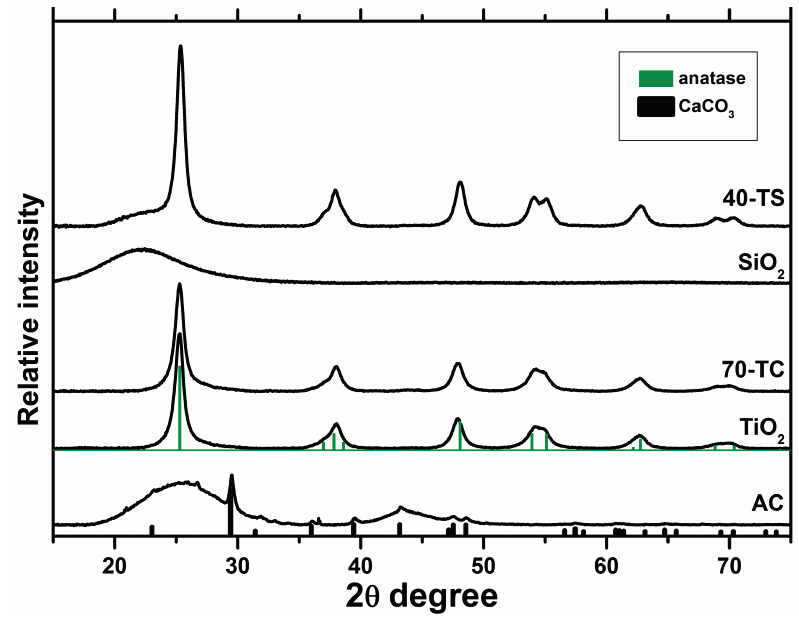
Figure 2. XRD patterns for the pure TiO 2 , AC, SiO 2 and for the composite 70-TC and 40-TS